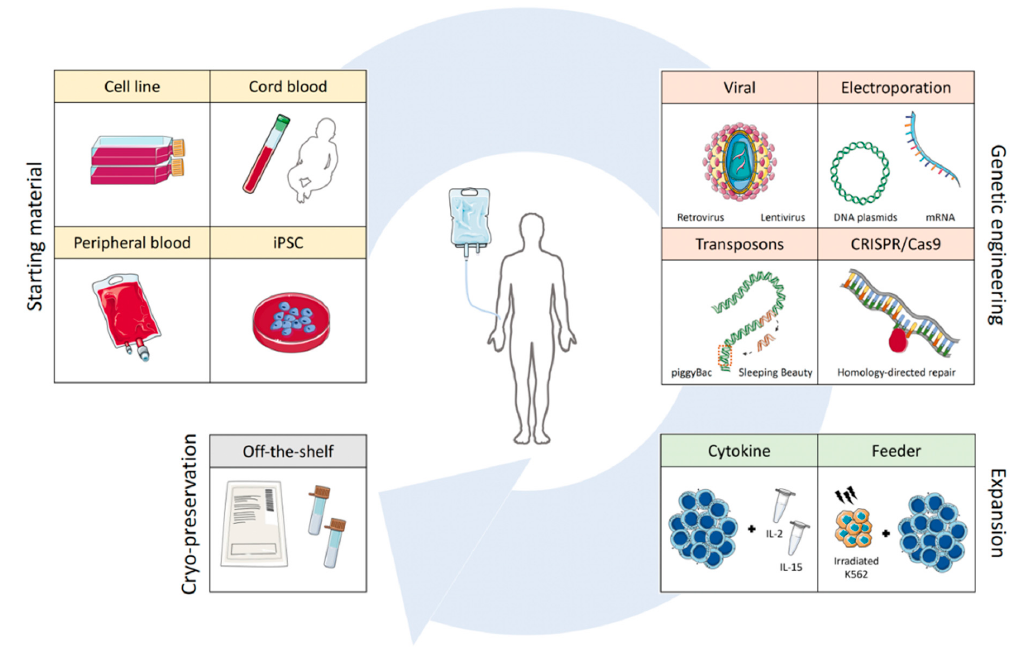
Figure 4. Overview of the CAR-NK cell manufacturing process. The four manufacturing stages of CAR-NK cell production, from the choice of starting material to genetic modification, product expansion, and the subsequent cryopreservation of treatment doses. Abbreviations: iPSC, induced pluripotent stem cell; CRISPR, clustered regulatory interspaced short palindromic repeats; IL-2, interleukin-2; IL-15, interleukin-15. IL-15,